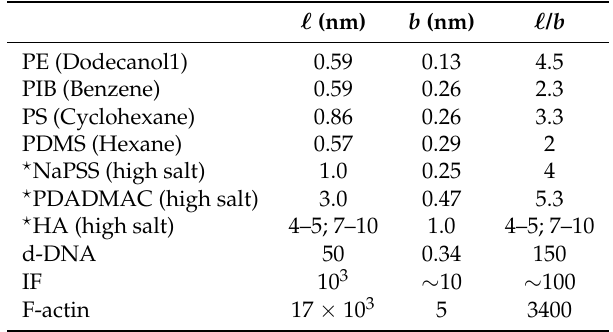
Table 1. Monomer size b along the backbone and persistence length (cid:96) for various polymers (in water if not specified otherwise) assuming worm-like-chain (WLC) statistics: polyethylene (PE) in dodecanol1, polyisobutylene (PIB) in benzene, polydimethylsiloxane (PDMS) in hexane, atactic polystyrene (PS) in cyclohexane, poly(sodium styrene sulfonate) (NaPSS), poly(diallyl-dimethyl ammonium chloride) (PDADMAC), hyaluronan (HA), duplex-DNA (d-DNA), intermediate filament vimentin (IF)